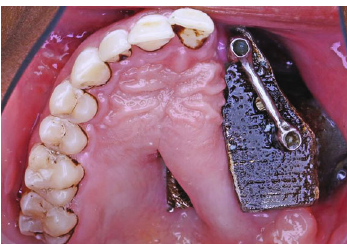
Figure 2: Intraoral occlusal view showing the bar after cementation.